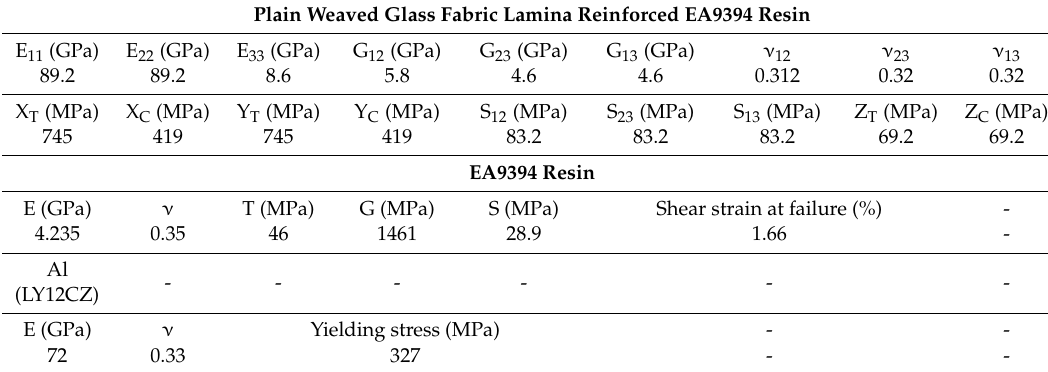
Table 3. Mechanical properties of SW90-a / EA9394 lamina.